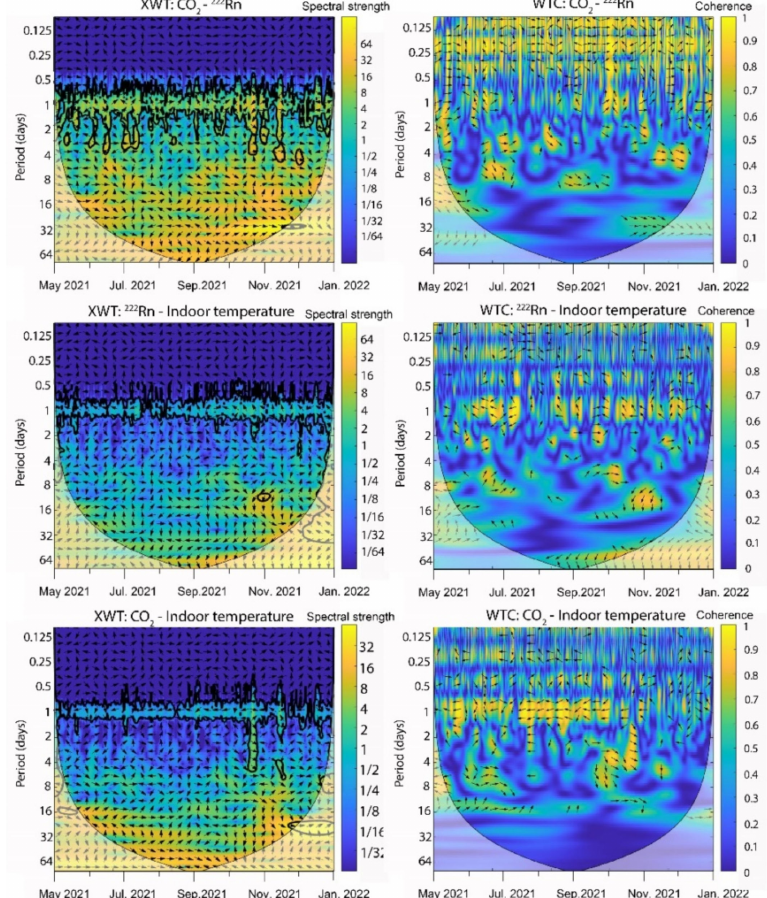
Figure 4. XWT and WTC between pair of signals: CO 2 and 222 Rn; 222 Rn and indoor temperature and CO 2 and indoor temperature. Spectral strength and coherence range from blue (weak) to yellow (strong) colors. Arrows indicate the relative phase relationship (in phase pointing right, antiphase pointing left, one signal leading the other by 90 ◦ pointing up/down). Curved lines on scalograms indicate the cone of influence where the edge effects are